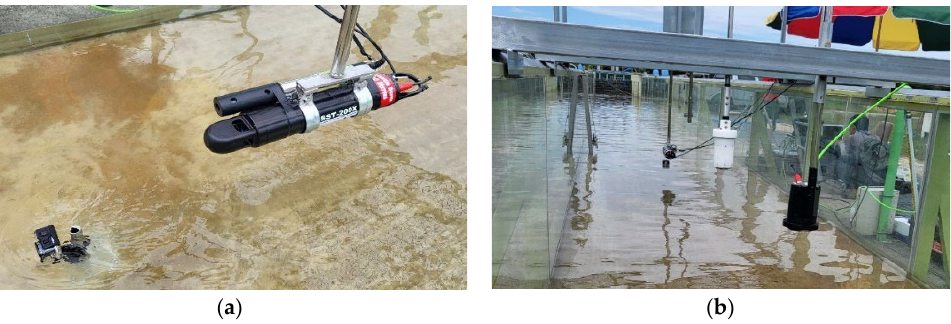
Figure 3. Measuring instruments used in the experiment: ( a ) WQC-30, LISST-200x, and GoPro 9 (Video-2 at 31.8 m), and ( b ) ADCP.